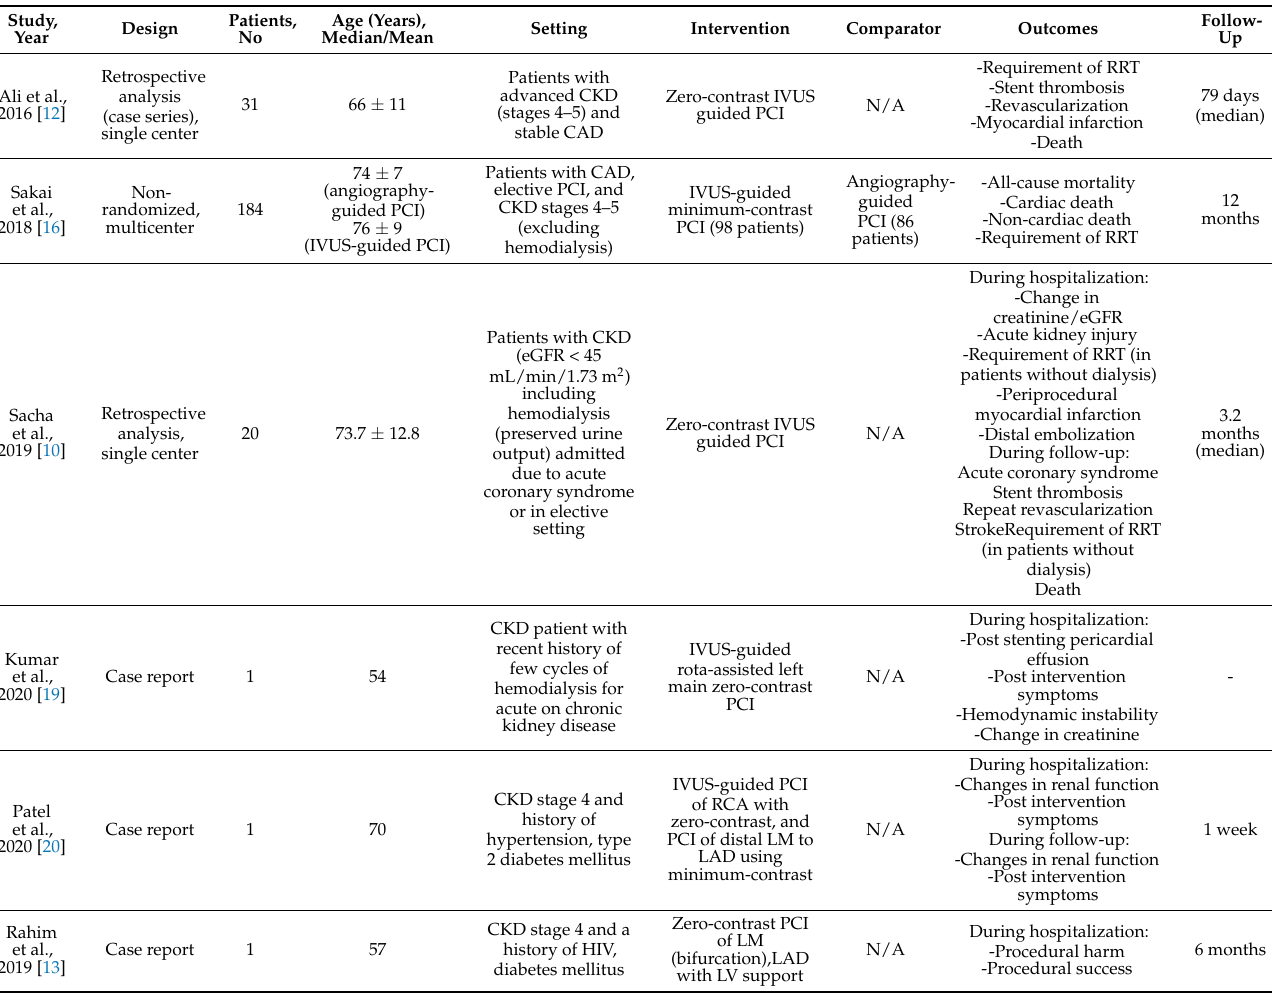
Table 2. General characteristics of studies included in systematic